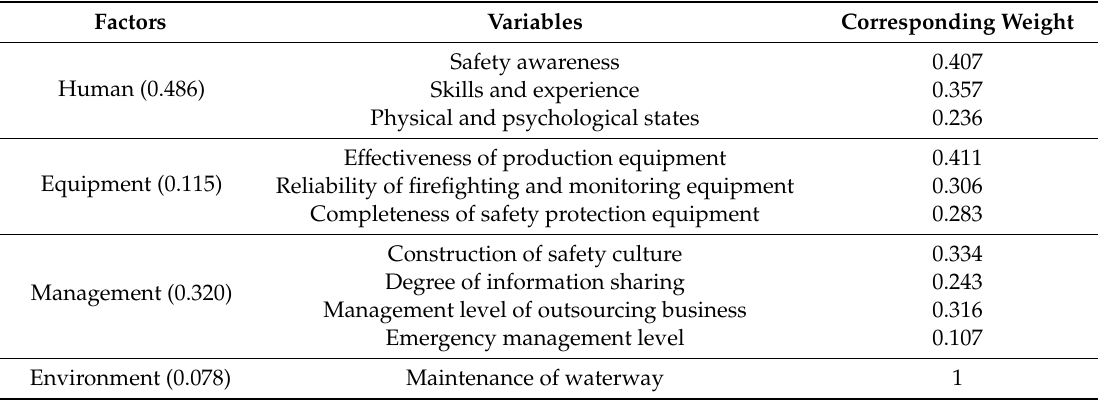
Table 3. Corresponding weights of factors and